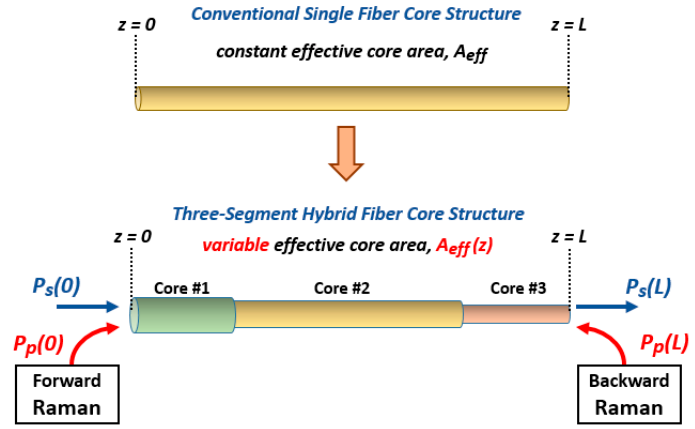
Figure 2. Schematic diagram of a bidirectional pumped Raman amplified span using three segments of optical fiber consisting of different fiber effective core area. Core #1 contributes to nonlinear Kerr effect reduction, core #2 works as a major transmission medium, and core #3 contributes to Raman gain optimization.